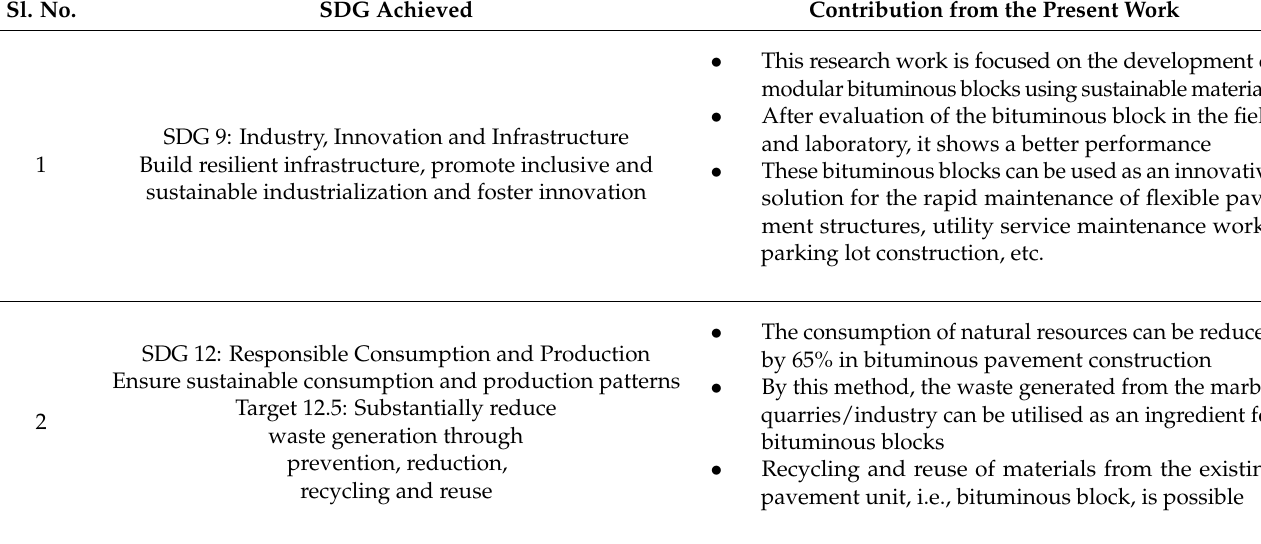
Table 10. Sustainable Development Goals Achieved by this Study.